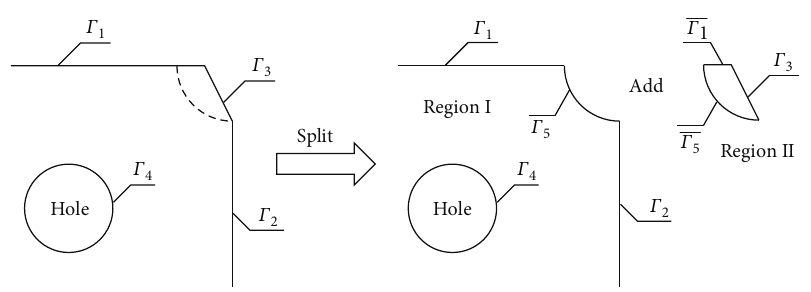
Figure 1: The virtual region decomposition model.